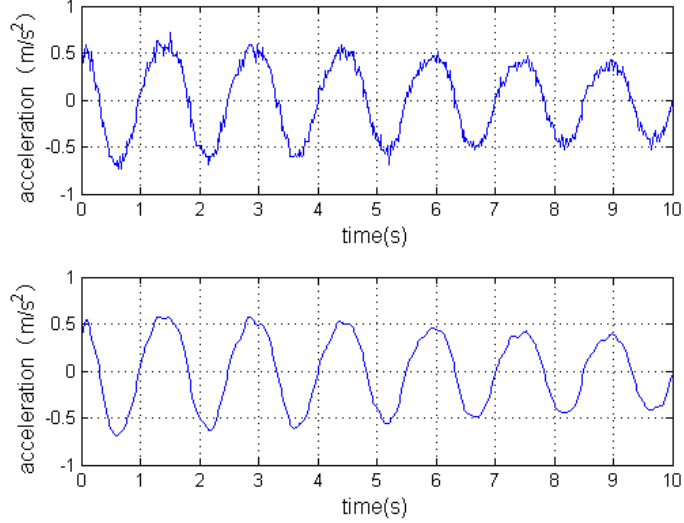
Figure 13. Comparison of the signals before and after low-pass filtering.